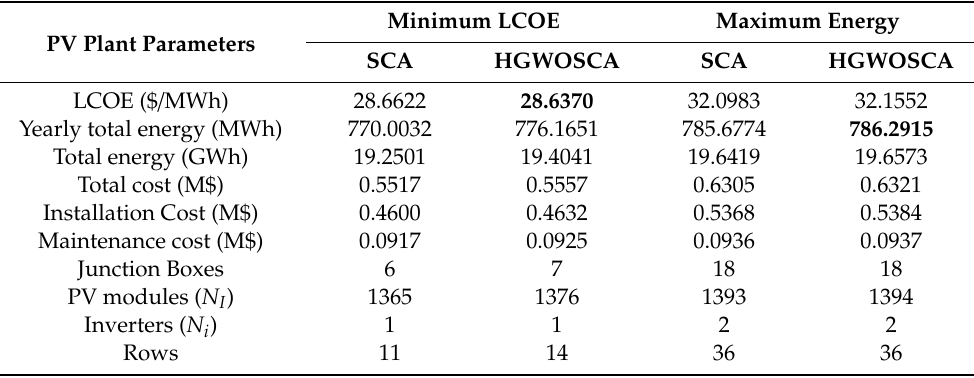
Table 10. Results of optimal design algorithms using hourly measurement data